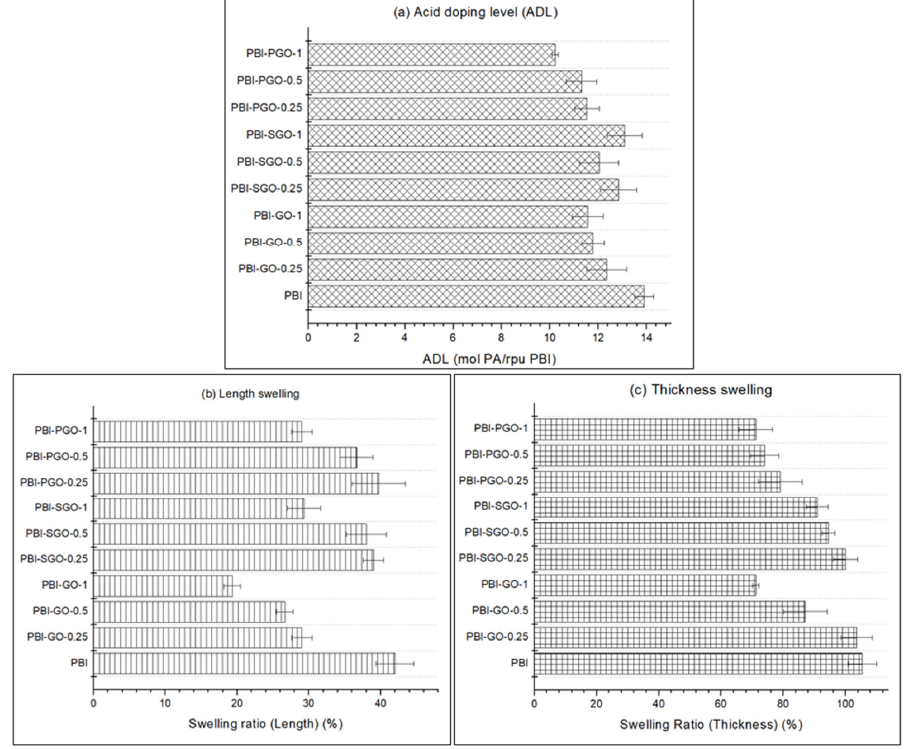
Figure 7. ( a ) Acid doping level (ADL), ( b ) length swelling, and ( c ) thickness swelling of PBI mem- branes.